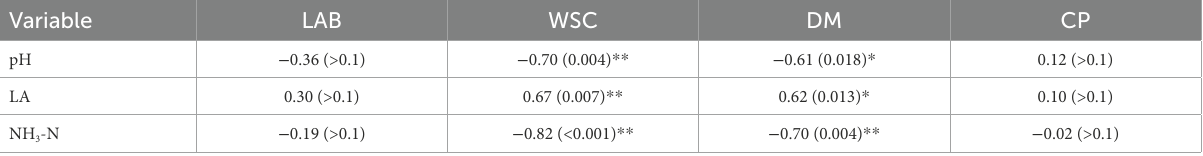
TABLE 4 Correlation coefficients ( r ) for relationships between chemical composition and fermentation silages after 60 days of ensiling.